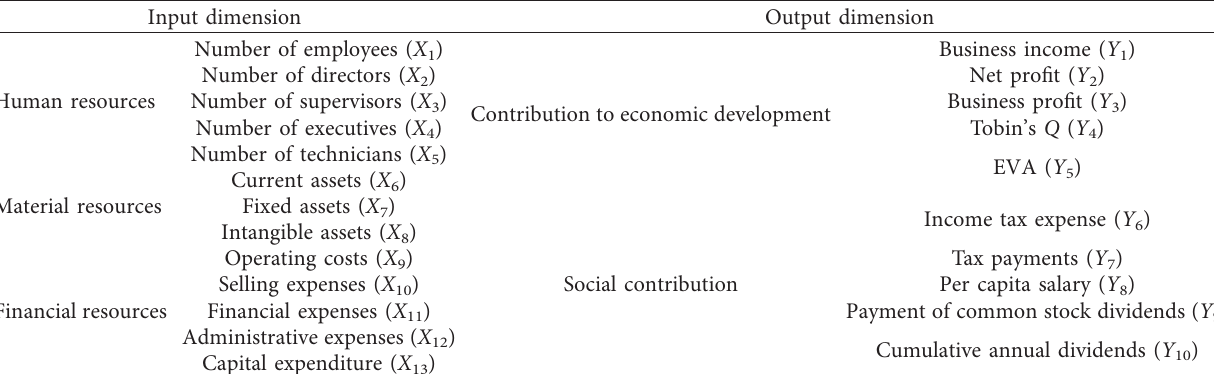
Table 1: Measurement index system of resource allocation efficiency.